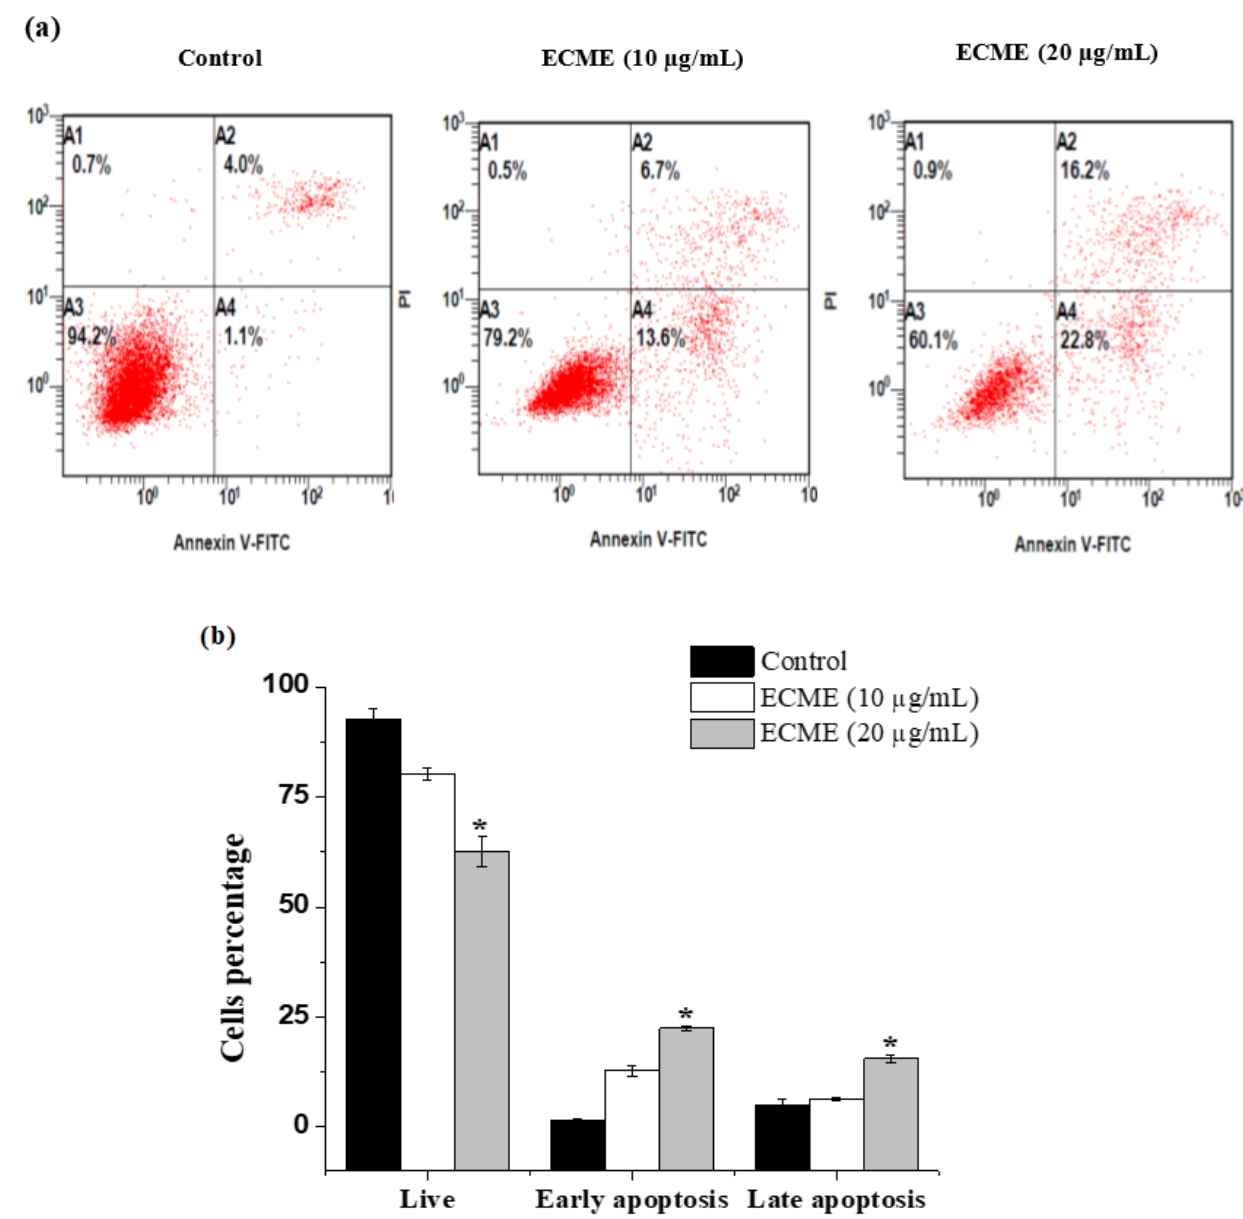
Figure 4. Apoptosis induction in A549 by ECME as detected by Annexin V/PI assay. ( a ) Apoptosis histogram of control cells, and cells treated with 10 and 20 µg/mL. A1: Cells labeled with PI only (necrosis), A2: cells labeled with annexin V and PI (late apoptosis), A3: Viable cells and A4: early apoptotic cells (Annexin V+/PI-) --). ( b ) Apoptosis percentage data from three experiments (mean ± SD, * p < 0.05 vs. control group).